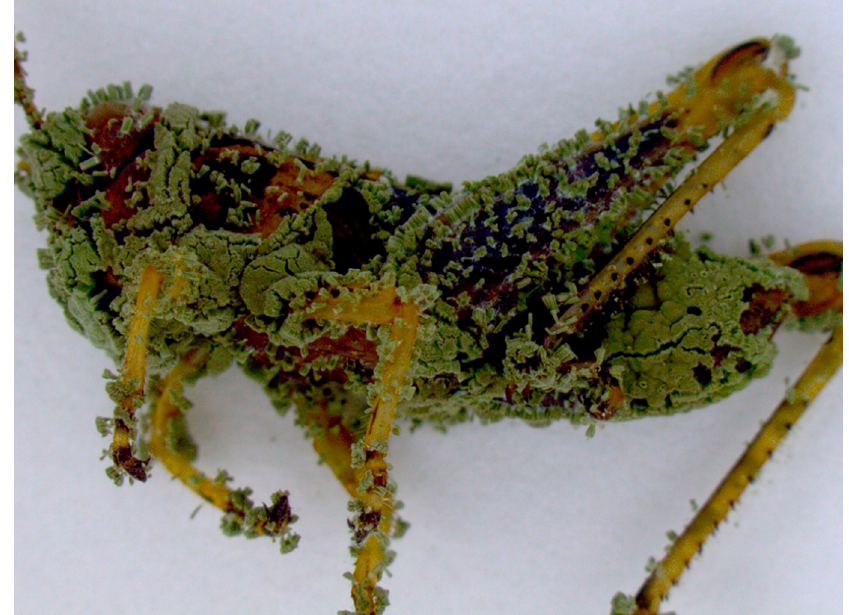
Figure 2. M. brunneum F52 sporulation on the body of grasshopper M. sanguinipes .